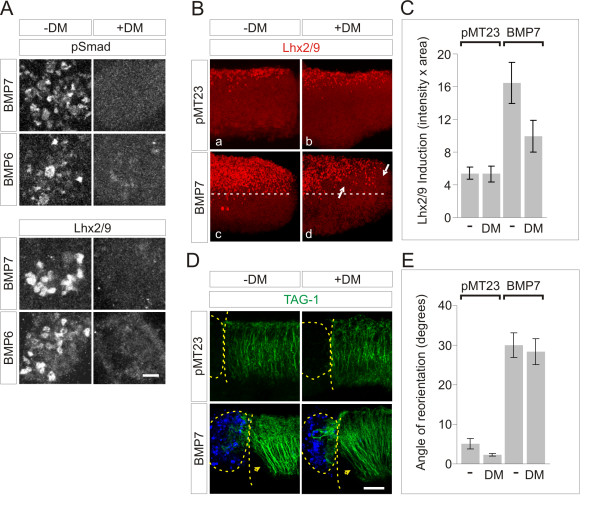
Type I BMP receptor kinase activity required for BMP7-evoked Lhx2/9 induction, but not axon orientation. (A) [i] explants treated with BMP7 or BMP6 (20 ng/ml) with or without DM (5 μM): α-pSmad1/5/8 (upper) and α-Lhx2/9 (lower) panels. Scale = 20 μm. (B-E) [d] explants, with appended control or BMP7-expressing COS-1 cells, with or without 10 μM DM. Explants co-labeled with α-Lhx2/9 (red) (B), and α-TAG-1 (green) and α-flag (blue) (C). Scale = 50 μm. (B) Endogenous Lhx2/9, induced prior to explantation, present only in the dorsal-most region of explants, cultured alone (not shown) or with pMT23-expressing COS-1 cells (a). DM did not alter endogenous Lhx2/9 (b). Dashed lines indicate ectopic ventral Lhx2/9 expression in [d] explants + BMP7-expressing COS-1 cells (c). DM treatment greatly reduced BMP7-induced ectopic Lhx2/9 (d, arrows). (C) Integrated density of Lhx2/9 expression (mean × 105 ± SEM for each condition): pMT23 - DM = 5.41 ± 0.77 (n = 3); pMT23 + DM = 5.33 ± 0.94 (n = 2); BMP7 - DM = 16.46 ± 2.51 (n = 5); BMP7 + DM = 9.94 ± 1.90 (n = 6). (D) Dashed lines mark appended borders of COS-1 cell aggregates and [d] explants. Arrowheads indicate dI axons repelled by BMP7. (E) Angles of reorientation in [d] explants with pMT23- or BMP7-expressing COS-1 cells with or without DM (pMT23 = 5.1 ± 1.3° (n = 3); pMT23 + DM = 2.3 ± 0.3° (n = 2); BMP7 = 30 ± 3.1° (n = 5); BMP7 + DM = 28.4 ± 3.3° (n = 5). Results are mean ± SEM for each condition. Student's t-tests: DM had no effect on the D-V projection of dI axons either in control (pMT23 versus pMT23 + DM; P = 0.1936) or BMP7-orienting conditions (BMP7 versus BMP7 + DM; P = 0.7345).